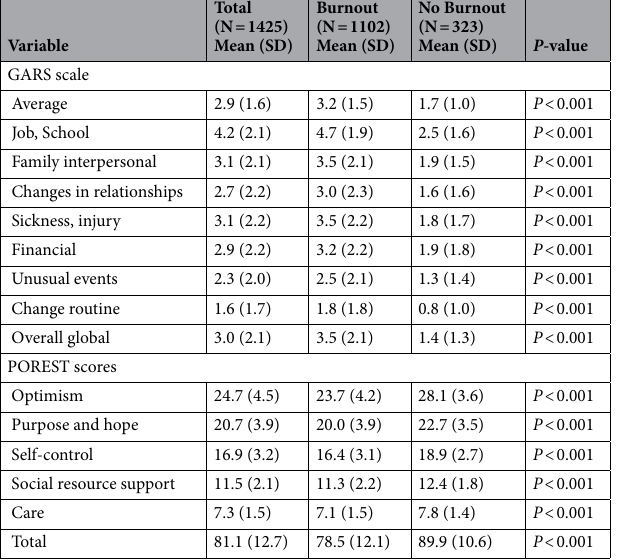
Table 5. The mean (SD) GARS scale and POREST scores according to burnout. GARS global assessment of recent stress scale, POREST positive resources test.